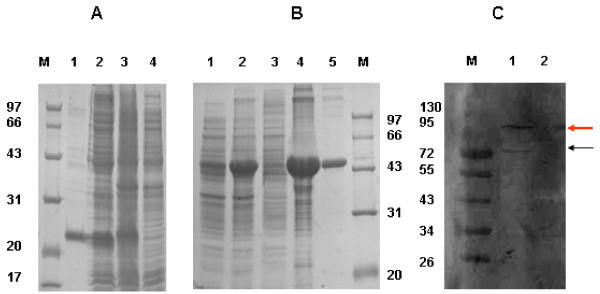
Western blot. ( A) SDS–PAGE analysis of the rSjTHRβ-DBD protein. Lane1: Purified rSjTHRβ-DBD protein (about 22 kDa). Lane2: Soluble fractions of expressed product of pET28a (+)-SjTHRβ-DBD induced with IPTG of the E. coli extract. Lane3: Expressed product of pET28a (+)-SjTHRβ-DBD induced with IPTG. Lane4: Expressed product of pET28a (+)-THRβ-DBD without induction. ( B) SDS–PAGE analysis of the rSjTHRβ-LBD protein. Lane1: Expressed product of pET32a (+)-SjTHRβ-LBD without induction. Lane2: Expressed product of pET32a (+)-SjTHRβ-LBD induced with IPTG. Lane3: Soluble fractions of expressed product of pET32a (+)-SjTHRβ-LBD induced with IPTG of the E.coli extract. Lane4: Insoluble fractions of expressed product of pET32a (+)-SjTHRβ-LBD induced with IPTG of the E.coli extract. Lane5: Purified rSjTHRβ-LBD protein (about 45 kDa) ( C) The protein extract of 21d schistosomes (lane1) and E.coli BL21 (DE3) (lane2) were probed with mouse serum specific to rSjTHRβ-LBD. The blots are representative of three replicates. M: protein marker.